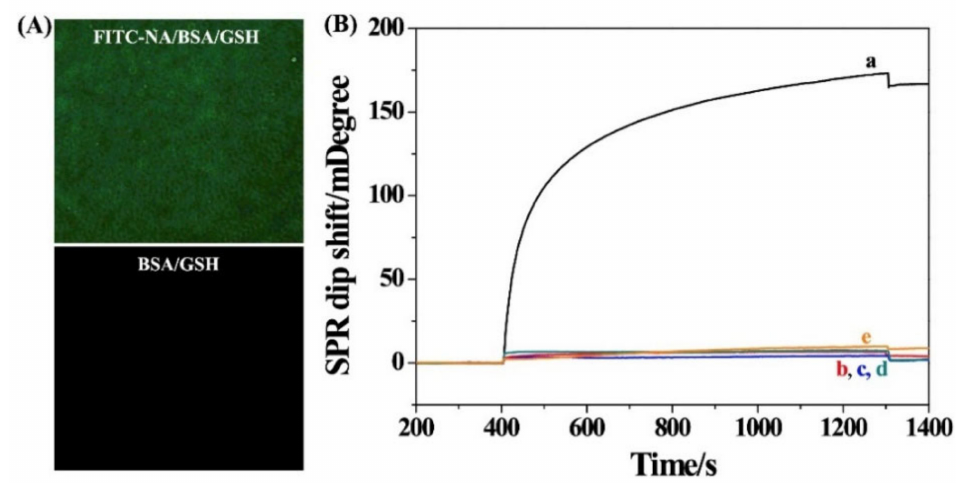
Figure 1. ( A ) Fluorescence microscopy images of the FITC–NA/BSA/GSH and BSA/GSH-modified chips. ( B ) SPR sensorgrams for injection of different hybrids onto the NA/BSA/GSH-modified chip: curve a, bio-DNA/T DNA /DNA-MNPs; curve b, DNA-MNPs; curve c, T DNA /DNA-MNPs; curve e, bio-DNA/T DNA /DNA. Curve d corresponds to that for injection of bio-DNA/T DNA /DNA-MNPs onto the BSA/GSH-modified chip. The concentration of T DNA was 1.5